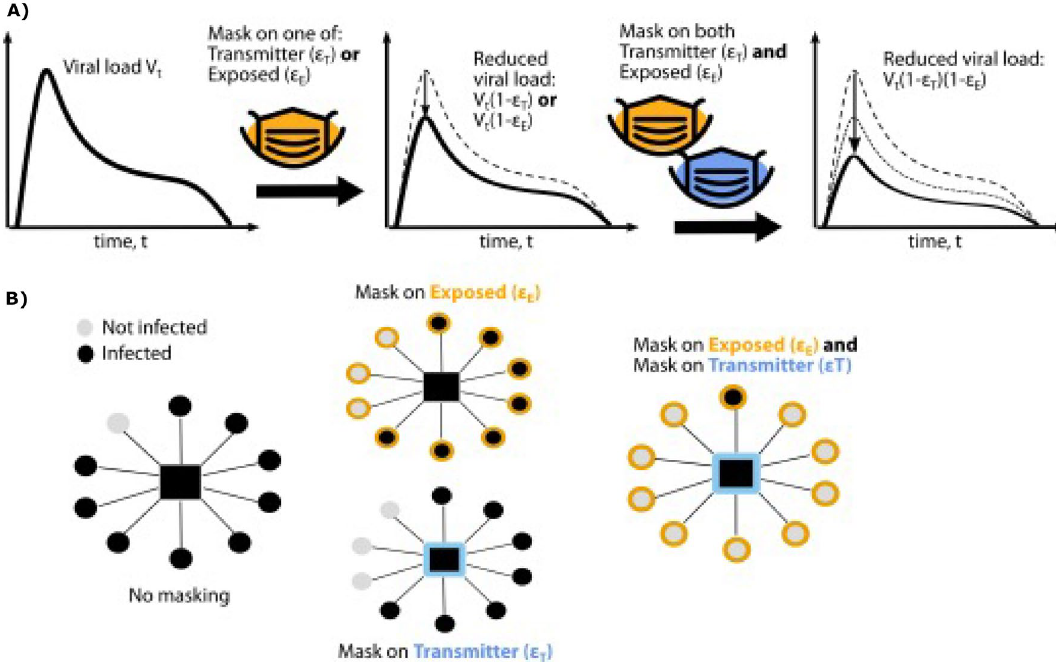
Figure 1. Schematic of mask impact on SARS-CoV-2 exposure viral load. ( A ) The viral load emitted by a potential transmitter (VT) can be filtered, resulting in lower exposure viral loads due to a single mask worn by a transmitter or exposed individual with efficacy ε T or ε E respectively. Dual masking lowers exposure viral load further by filtering virus twice. ( B ) Dual masking may prevent super-spreader events to a greater extent than a masked transmitter or masked exposed individual.